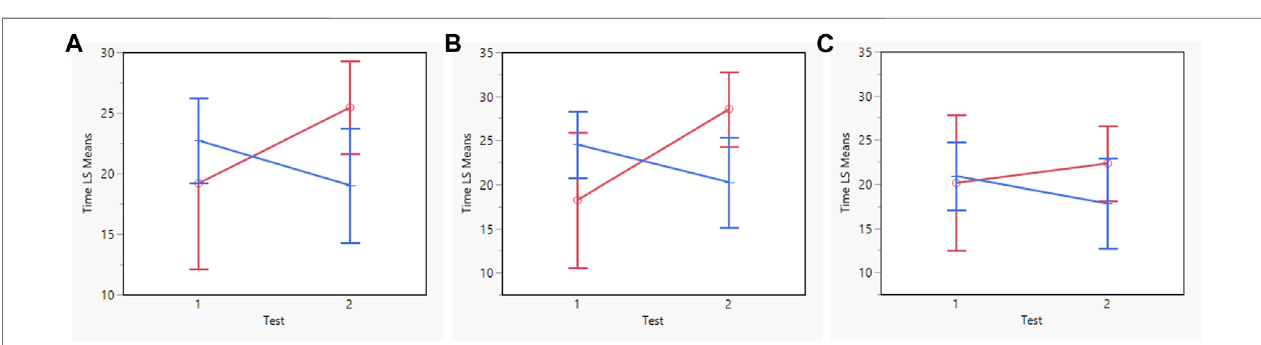
FIGURE 6 | LS means plots of overall (A) , 2D (B) , and 3D (C) IMRT time for male (blue) and female (red) participants completing Test 1 (simple VE) and Test 2 (complex VE).